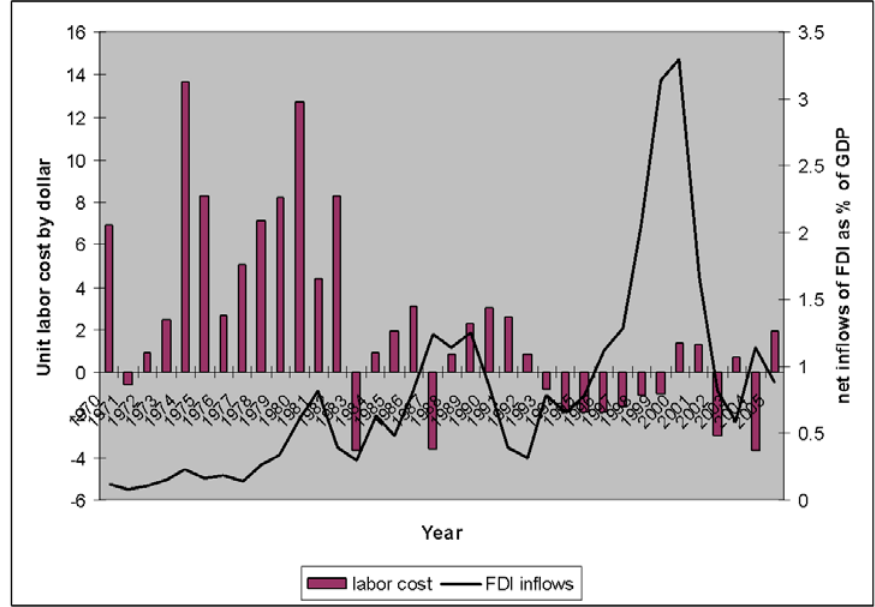
Figure 1: The Change of Labor Cost and FDI Net Inflows: